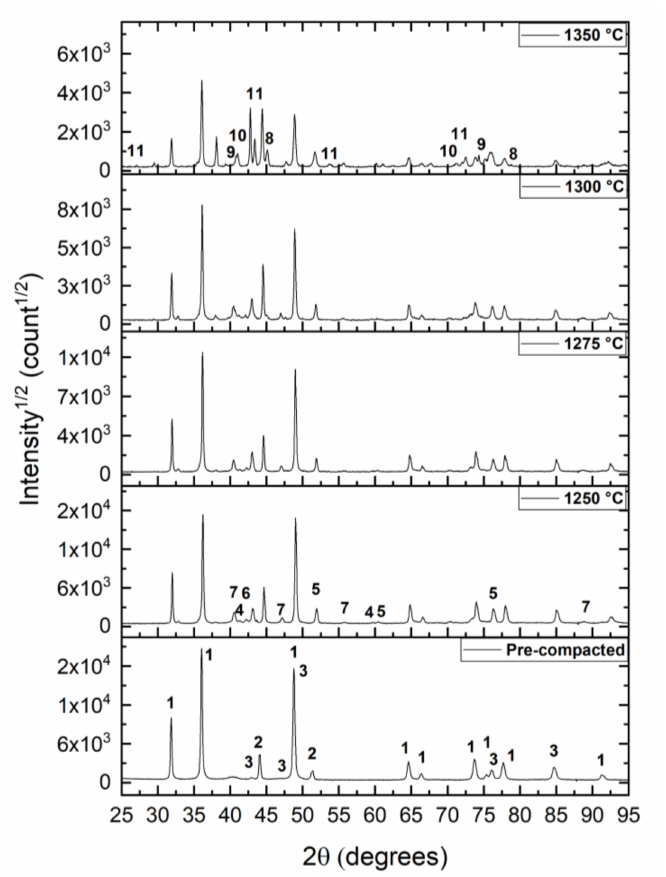
Figure 5. X-ray diffraction patterns of the 70 wt.% WC and 30 wt.% IN 625 mixture after compaction and sintering at different